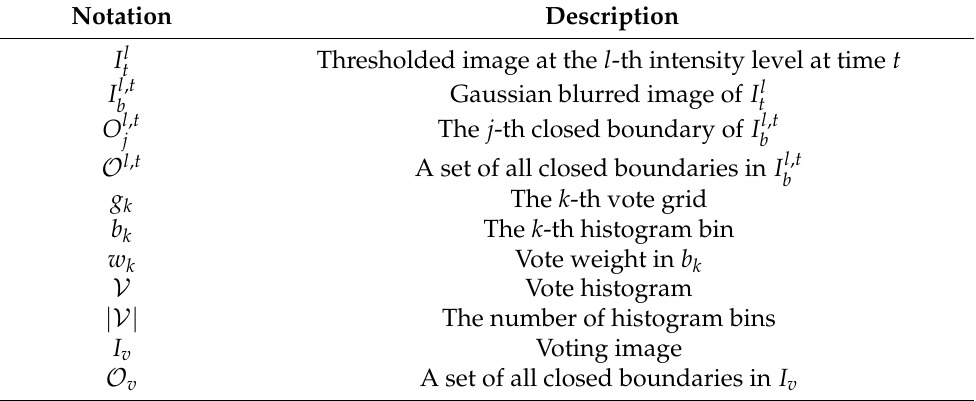
Table 1. Description on